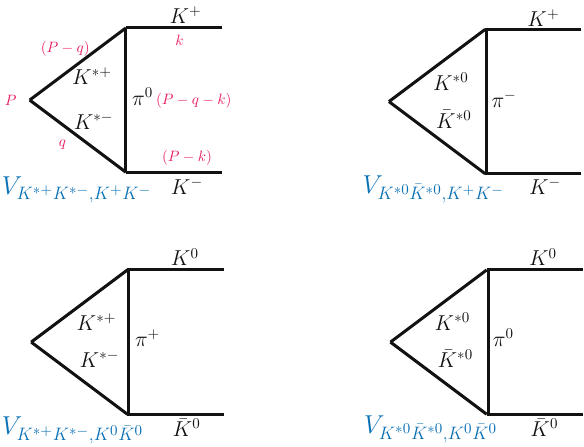
Fig. 2 Triangle loop functions for the evaluation of V